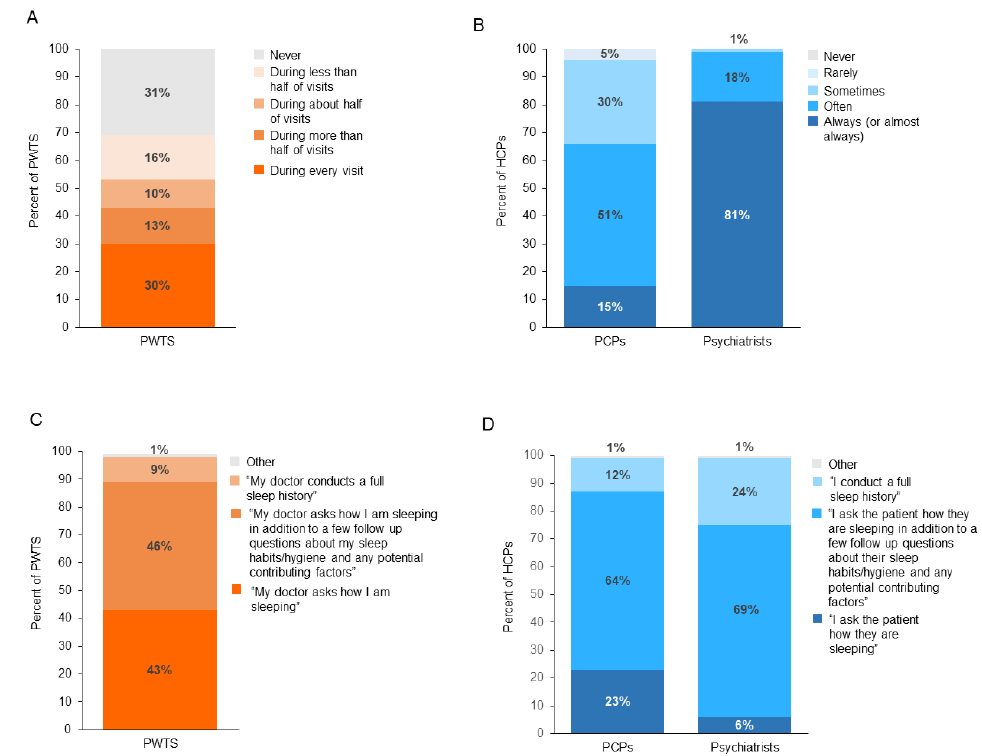
Figure 4. Perceived differences between PWTS and HCPs on sleep discussions. ( A ) PWTS reported the frequency of their PCP asking about sleep and sleep habits during routine visits ( B ), and the frequency HCPs reported asking their patients about sleep and sleep habits during routine visits. ( C ) The types of sleep conversations PWTS report having with PCPs ( D ) and the types of conversations HCPs report having with their patients during routine visits. Due to rounding completed by the Harris Poll, percentages may add up to more than 100%. HCP, health care professional; PCP, primary care physician; PWTS, people with trouble sleeping.